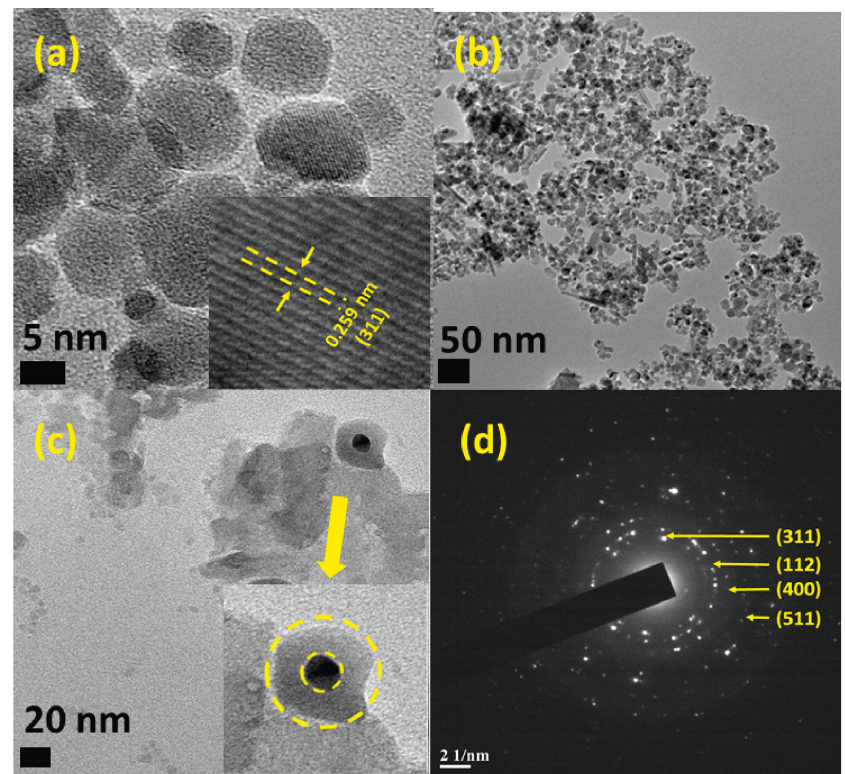
Figure 3: TEM images of (a) Fe 3 O 4 NPs, (b, c) Fe 3 O 4 @SiO 2 , and (d) the SAED pattern of Fe 3 O 4 @SiO 2 @SO 3 H